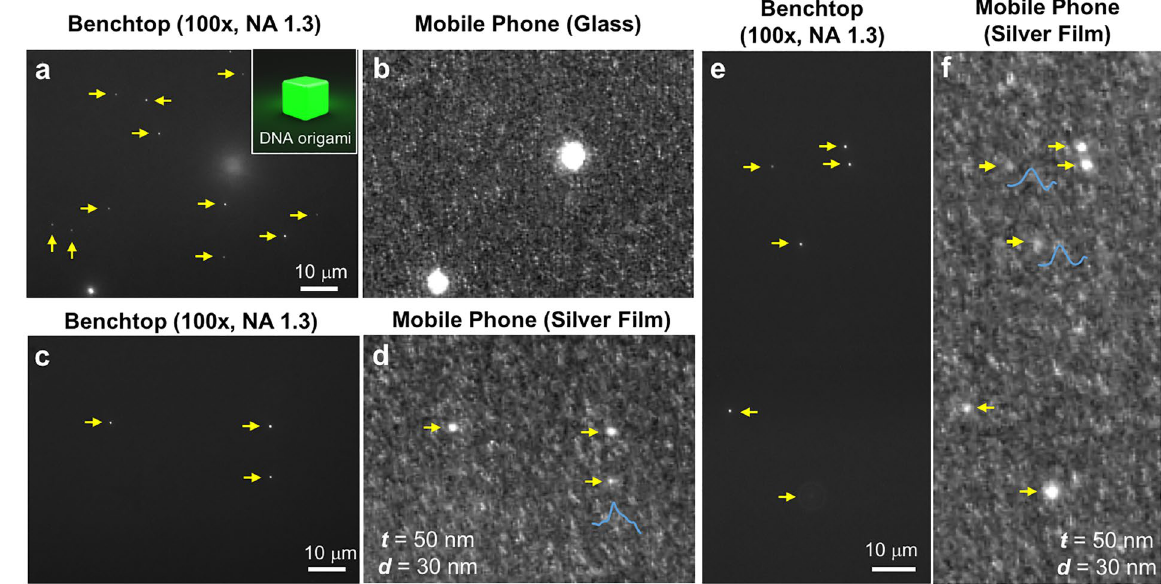
Figure 6. Imaging of single DNA origami nanobeads labeled with 80 ± 4 fluorophores, each. ( a , b ) Control experiments for imaging the DNA origami nanobeads using a glass-based mobile phone microscope ( b ), and the same region of interest imaged by a benchtop microscope ( a ). A schematic illustration of a fluorescent DNA origami nanobead is shown in the inset of ( a ). ( c – f ) Detection of single 80-fluorophore DNA origami nanobeads with our smartphone-based SEF microscope. The sample was imaged by both a benchtop microscope ( c , e ) and our smartphone-based SEF microscope ( d , f ) to validate the detection of single DNA origami nanobeads. DNA origami nanobeads are highlighted by the yellow arrows and the intensity line scans of three weaker ones are also shown (blue curves). In ( e ) the bottom yellow arrow points to an out-of-focus fluorescent origami